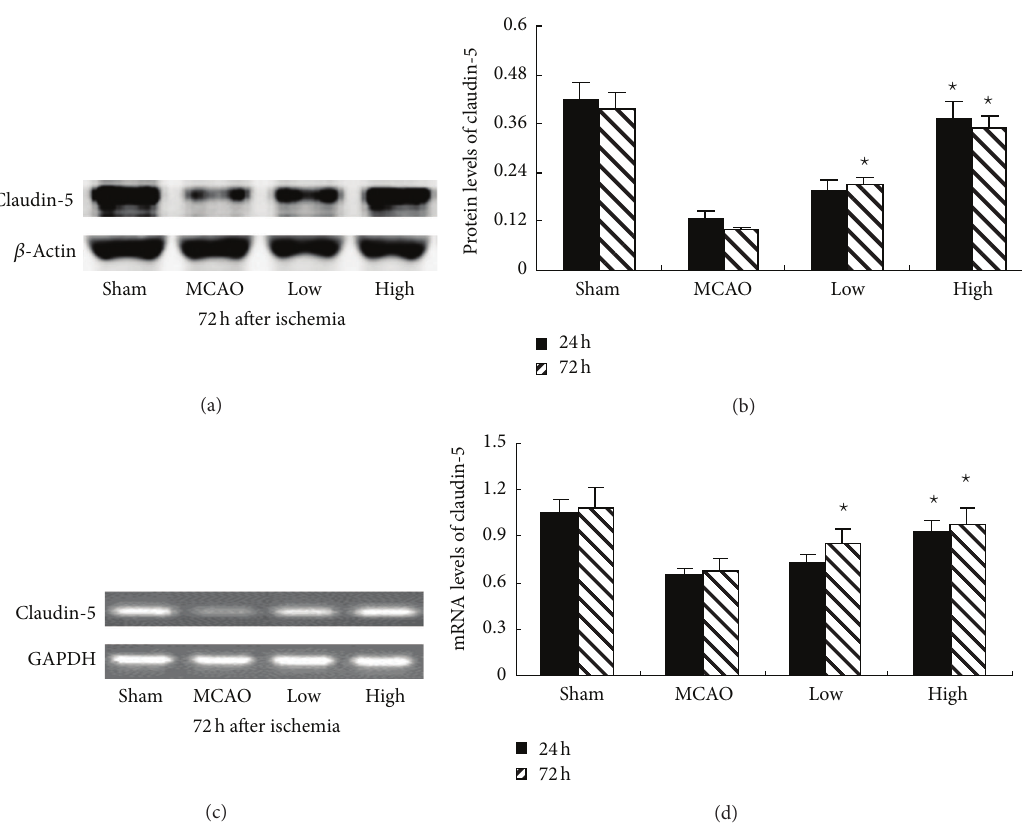
Figure 6: PN increased the expression of claudin-5 after MCAO. The expression of claudin-5 was assessed by western blot ((a) and (b)) and reverse transcription-polymerase chain reaction ((c) and (d)). Compared with MCAO group, the expression of claudin-5 was significantly increased in High group both at 24h and 72h, but increased only at 72 h in Low group ⋆ 𝑃 < 0.05 versus MCAO